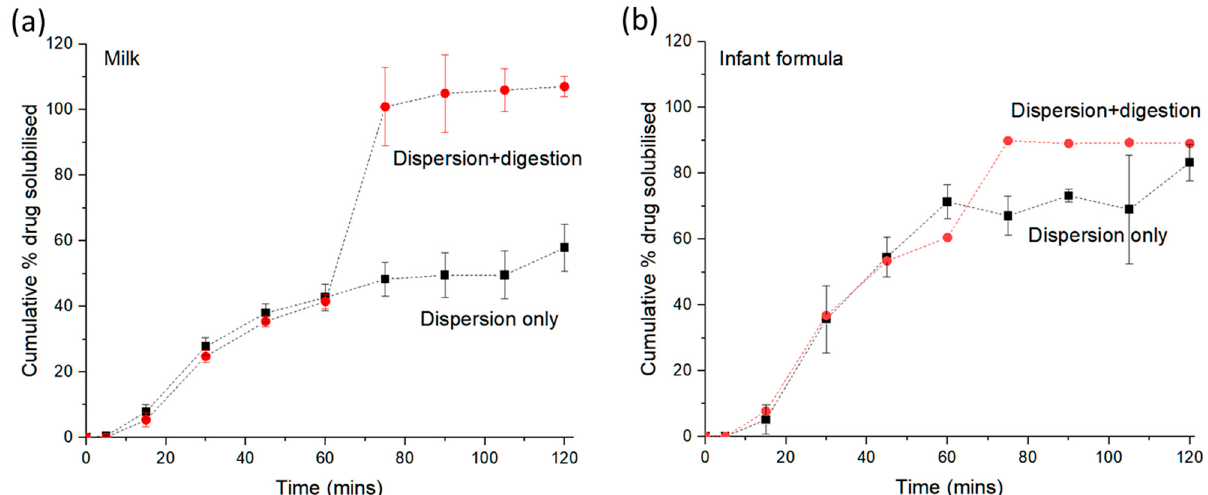
Figure 3. Solubilisation of praziquantel during either dispersion alone or dispersion followed by digestion in ( a ) milk and ( b ) infant formula. Biltricide ® (600 mg praziquantel tablet) was dispersed in 800 mL of milk or infant formula (black square; ‘dispersion only’, n = 3) and for the digestion data set, pancreatic lipase was added after 60 min dispersion to initiate digestion (red circle; ‘dispersion + digestion’, n = 2 for infant formula). Dashed lines are drawn as a guide to the eye.